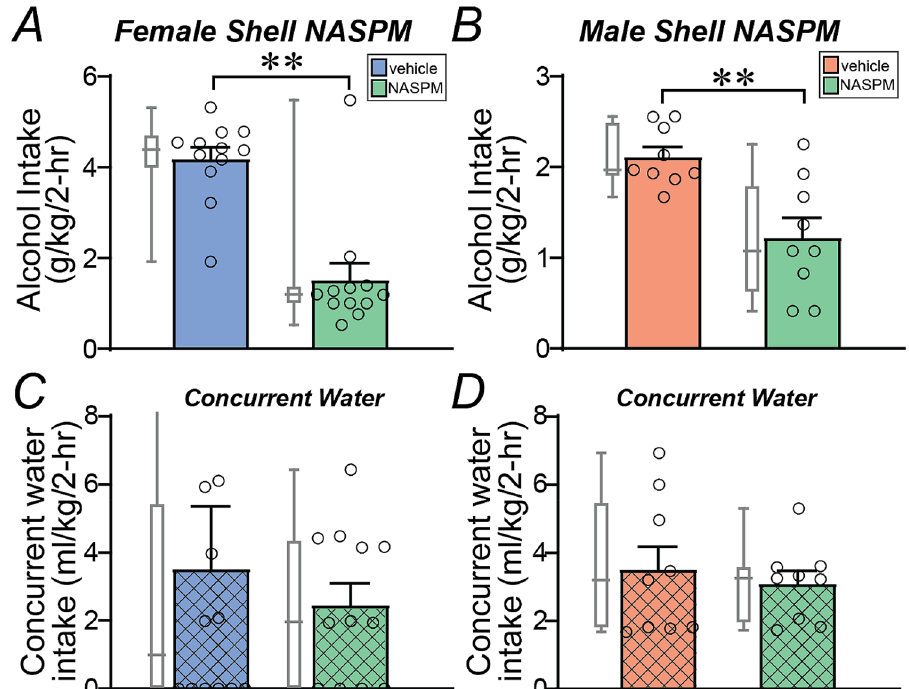
Figure 3. Shell CP-AMPAR inhibition reduced alcohol binging in both sexes. ( A , B ) Intra-shell infusion of the CP-AMPAR inhibitor NASPM significantly and strongly reduced alcohol-only drinking in both ( A ) females